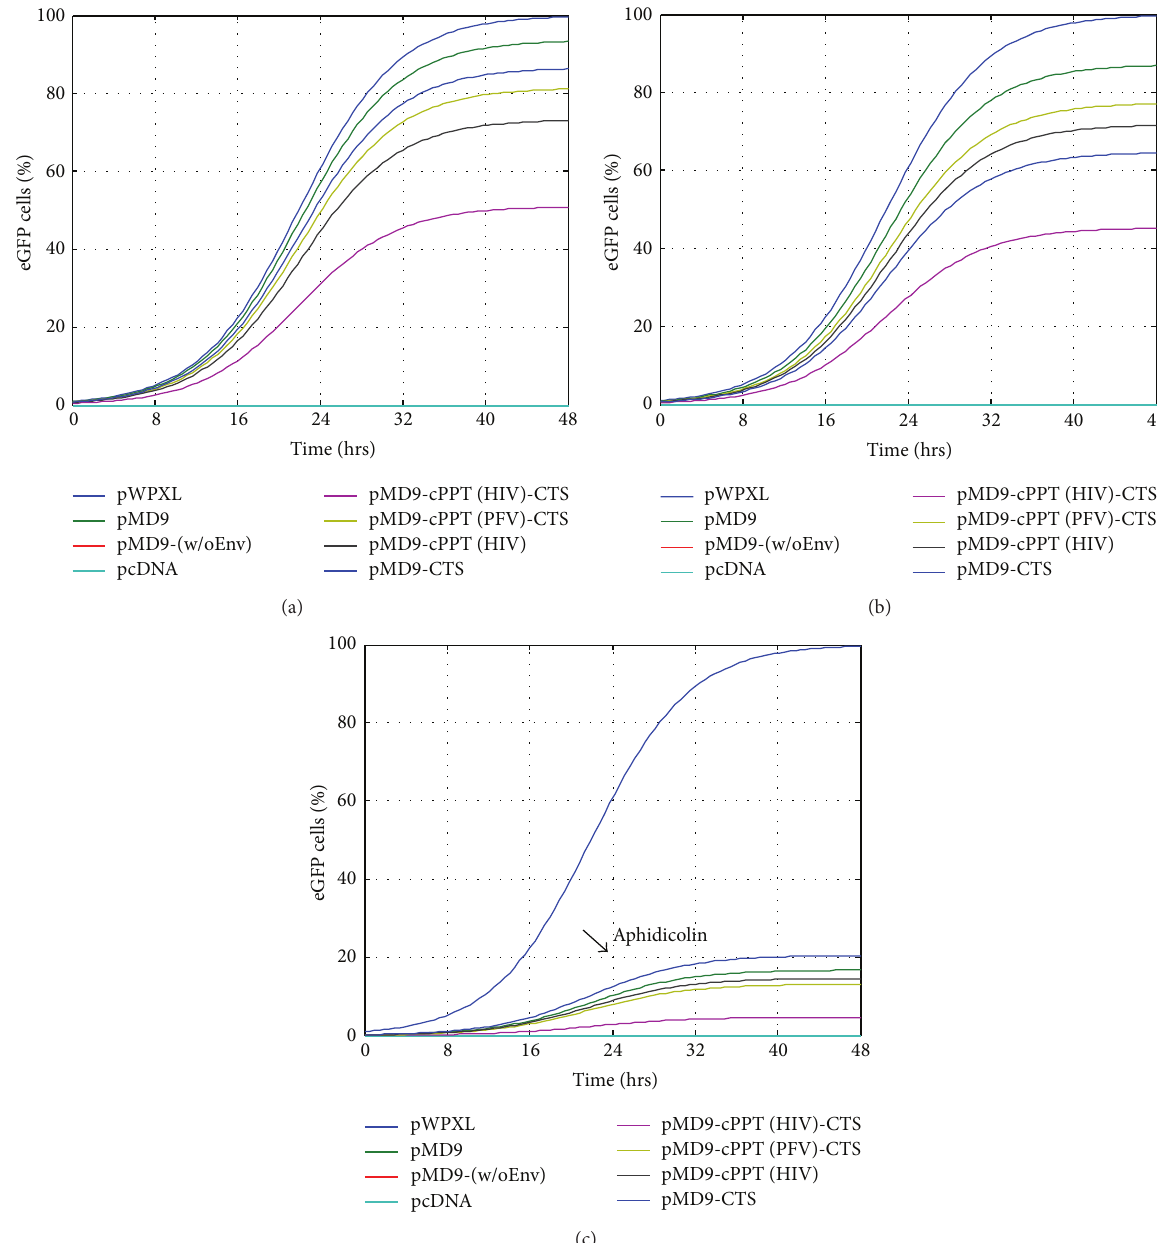
Figure 7: Dynamic 𝑓(𝑥) function: logistic dose-response curve to predict and model viral infection cycle of retroviral replication efficiency td in the A549 cells. The pMD9-based plasmids were tested to efficiently transduce dividing and growth-arrested cells (G 1 /S phase of cell cycle). Three conditions were analysed in the experiment: control (a); DMSO (b); aphidicolin